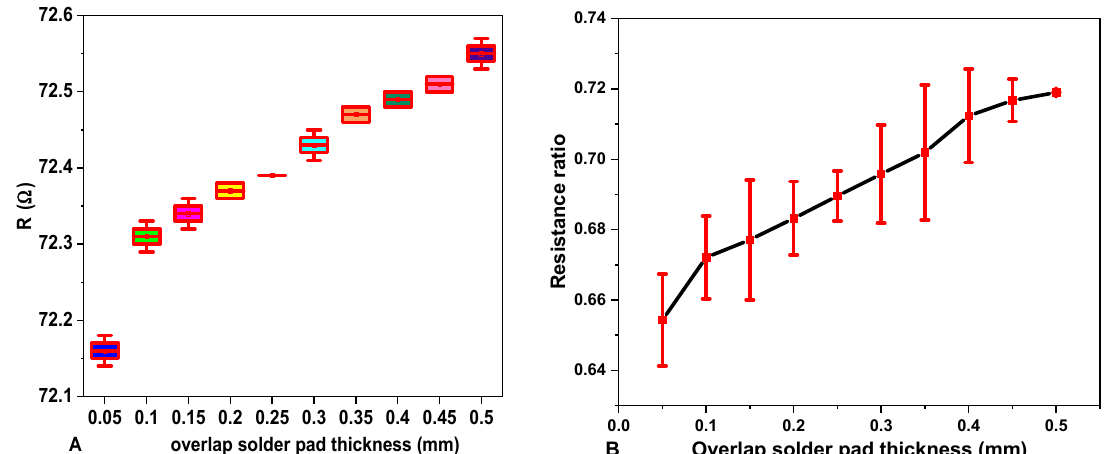
The total electrical resistance of the E- yarn is a direct function of the resistance of left SCV-conductive yarn, left connector solder-pad resistance, and resistance of the SMD resistor, right connector solder pad, and right SCV-conductive yarn. Therefore, the average total resistance of E-yarn is 72.16 Ω per 0.31 m length. The resistance ratio R R with one mm solder pad (connector) overlap length is 66.58%. The effect of solder pad overlap size on the total resistance of the E-yarn and the resistance ratio are shown in Figure 15A,B, respectively.